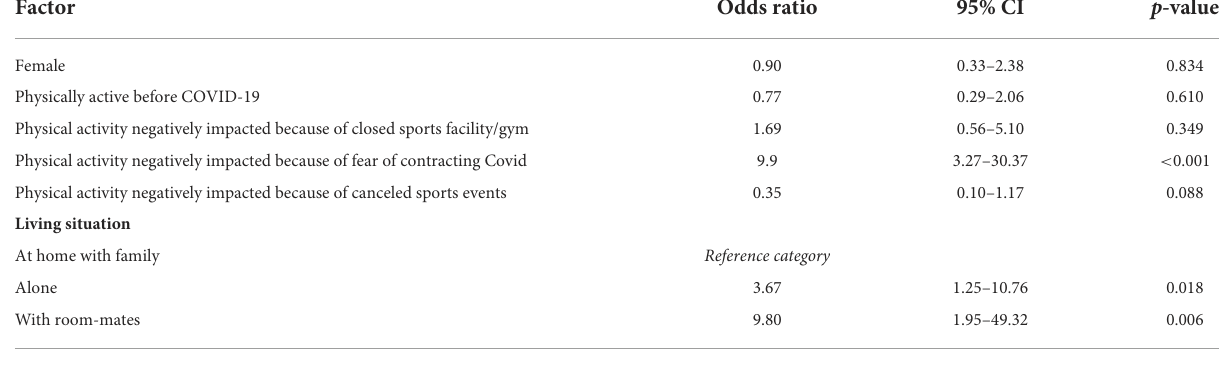
TABLE 5 Factors associated with decreased PA ( N =